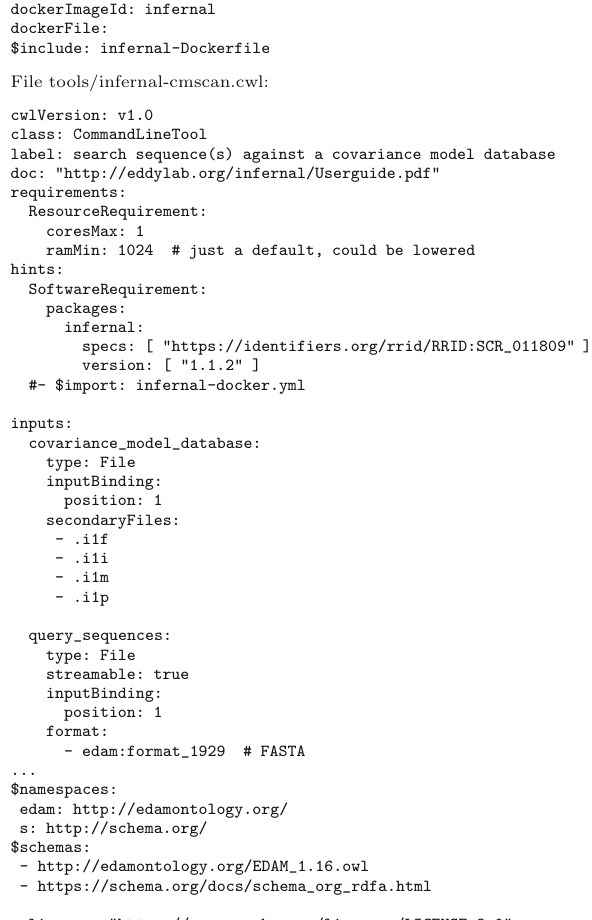
Table 3 Example CWL tool descriptions from EBI Metagenomics